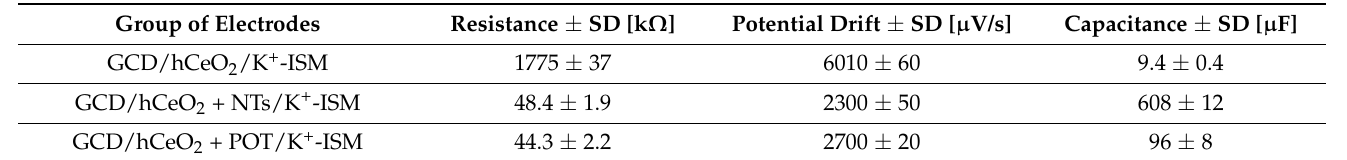
Table 1. Calibration curves parameters calculated for one electrode representing each group after 24, 48 and 72 h of conditioning ( n =